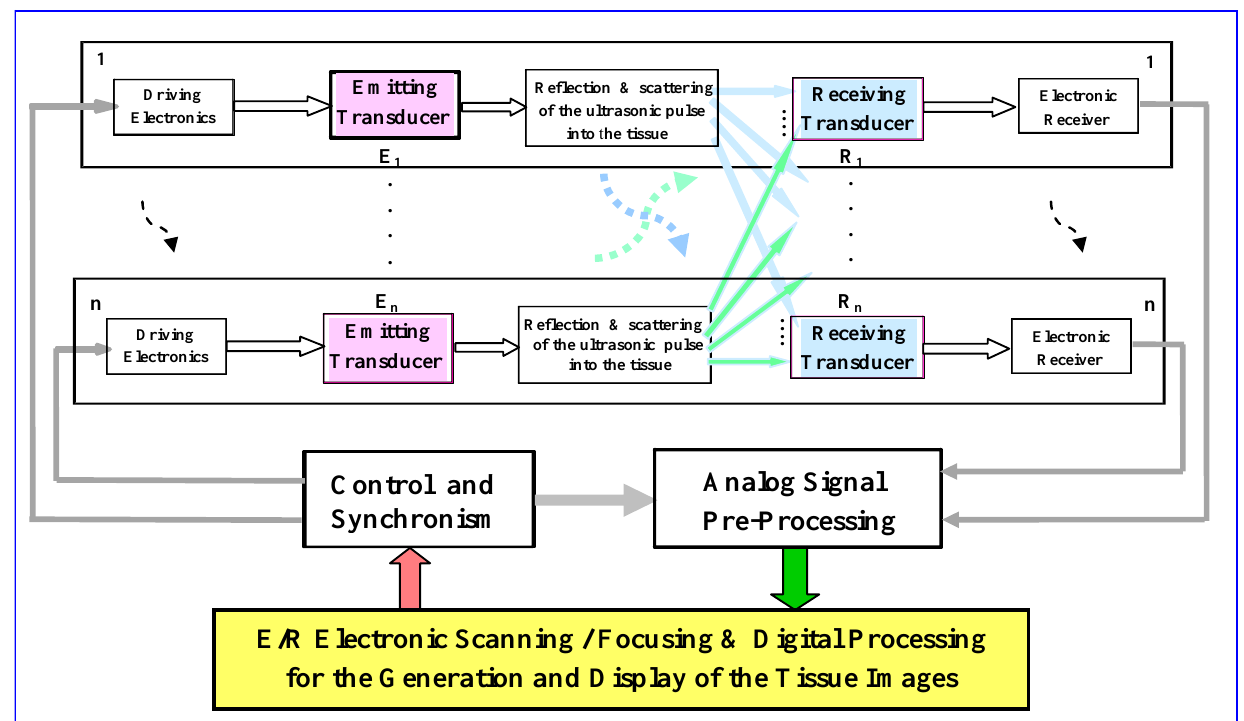
Figure 1. Schematic diagram of the systems developed for ultrasonic echo-imaging using arrays of n